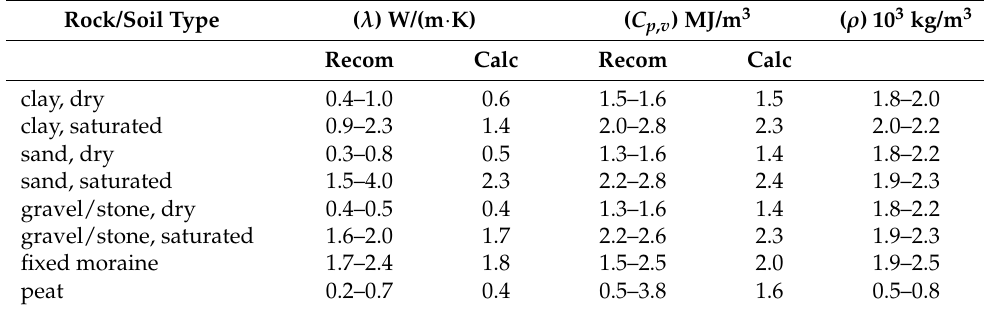
Table 1. Soil and material properties [18].